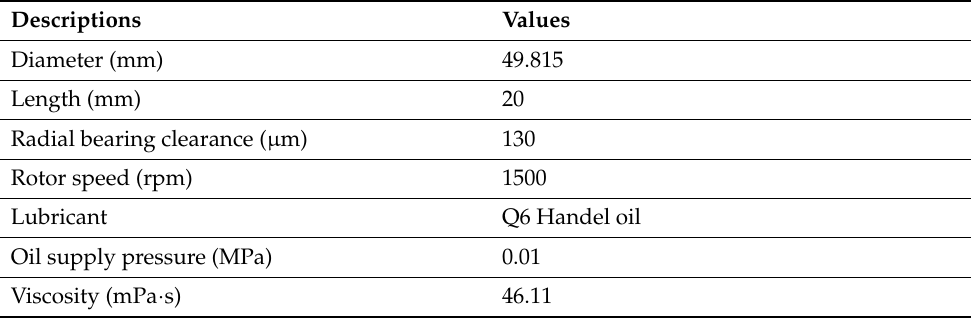
Figure A3. Schematic representation of a plain cylindrical journal bearing. Table A3. Plain cylindrical journal bearing parameters.